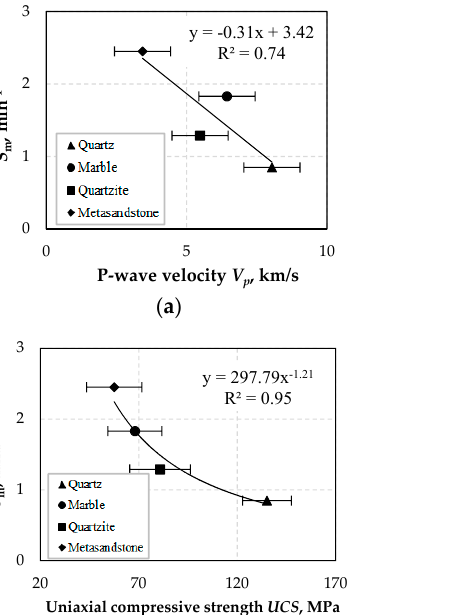
Figure 13. Correlations between maximum breakage rate S m and ( a ) P-wave velocity V p , ( b ) Schmidt rebound values R L , ( c ) uniaxial compressive strength UCS and ( d ) tangent modulus of elasticity E t ; horizontal error bars show standard deviation of the measurements.